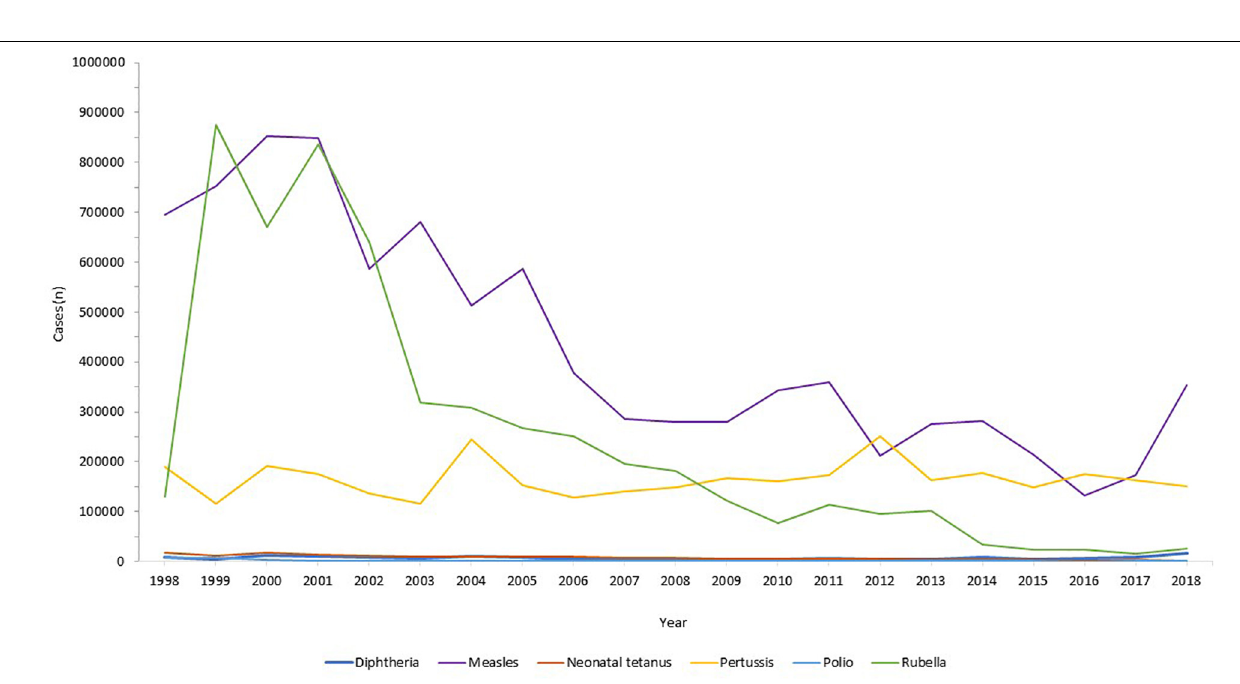
FIGURE 3 | Reduction in infectious diseases globally. Across all world regions, data from the WHO, for the last 20 years showing the control of diphtheria and tetanus and the decline in rubella and congenital rubella syndrome (data not shown). Data from the World Health Organization dataset “Reported cases of vaccine-preventable diseases” (World Health Organisation,